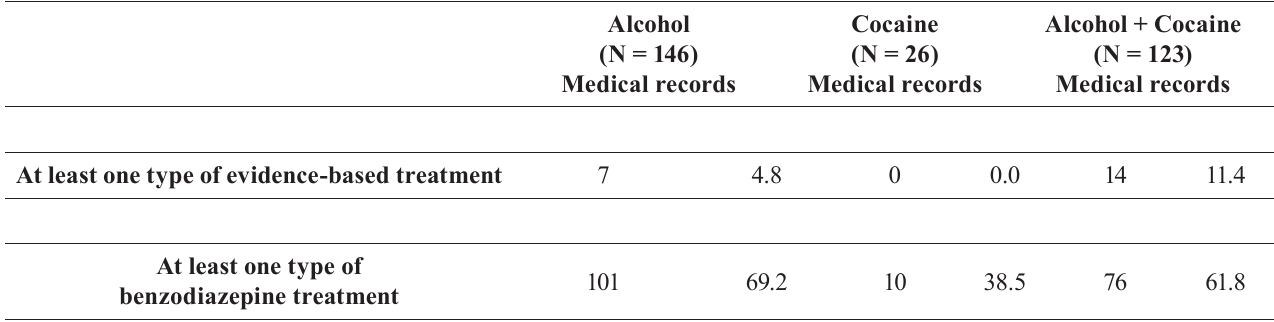
Brazilian Medical Association and Federal Council of Medicine for alcohol (Campana et al. , 2012) and cocaine